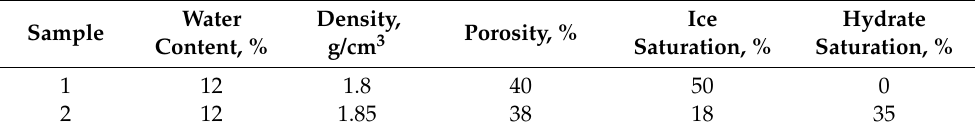
Figure 3. Time-dependent temperature variations between frozen sand and a 0.4 N NaCl solution at 0.1 MPa, at 2.5 cm to the contact. 1 = hydrate-free frozen sand (dotted line); 2 = hydrate-bearing frozen sand (solid line); 3 = initial temperature (t in ) − 6.5 ° С (dashed line). The temperature distribution along the frozen samples with and without pore me- Table 3. Properties of hydrate-free (sample #1) and hydrate-saturated (sample #2) frozen thane hydrates departed from the initial − 6.5 ° С value after 0.6 h of interaction with a 0.4 N NaCl solution (Figure 4), more strongly in the case of the hydrate-saturated sample.